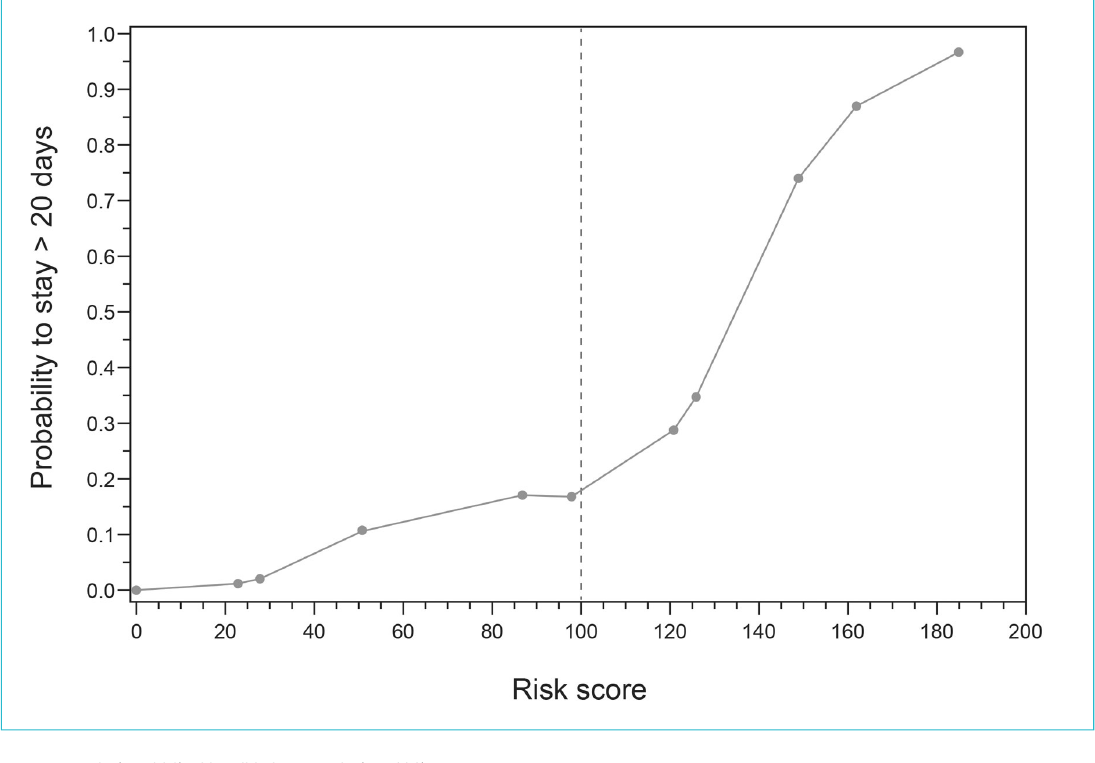
Table 5: Comparison of development sample (n = 304) with validation sample (n =